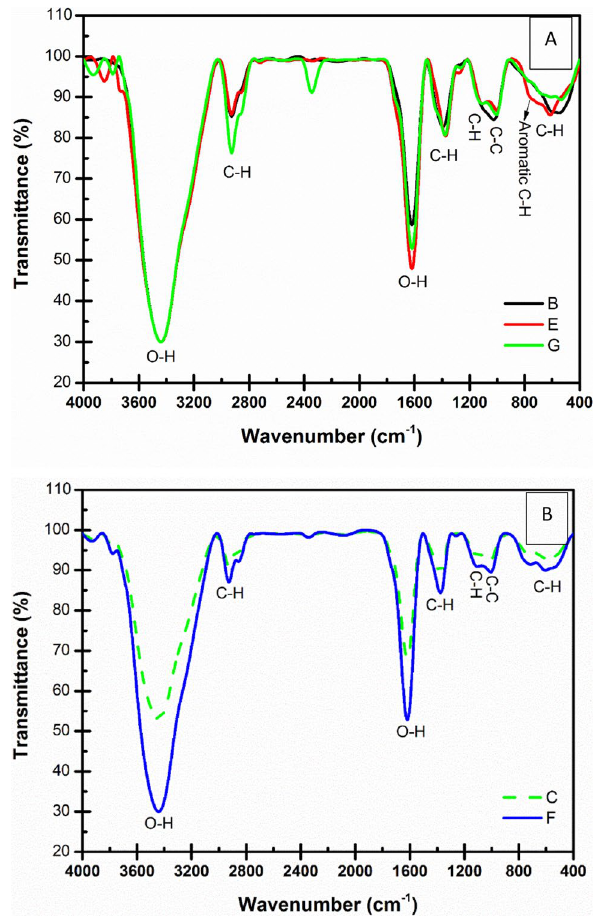
Fig. 3 The FT-IR spectrums of samples based on a PP and b